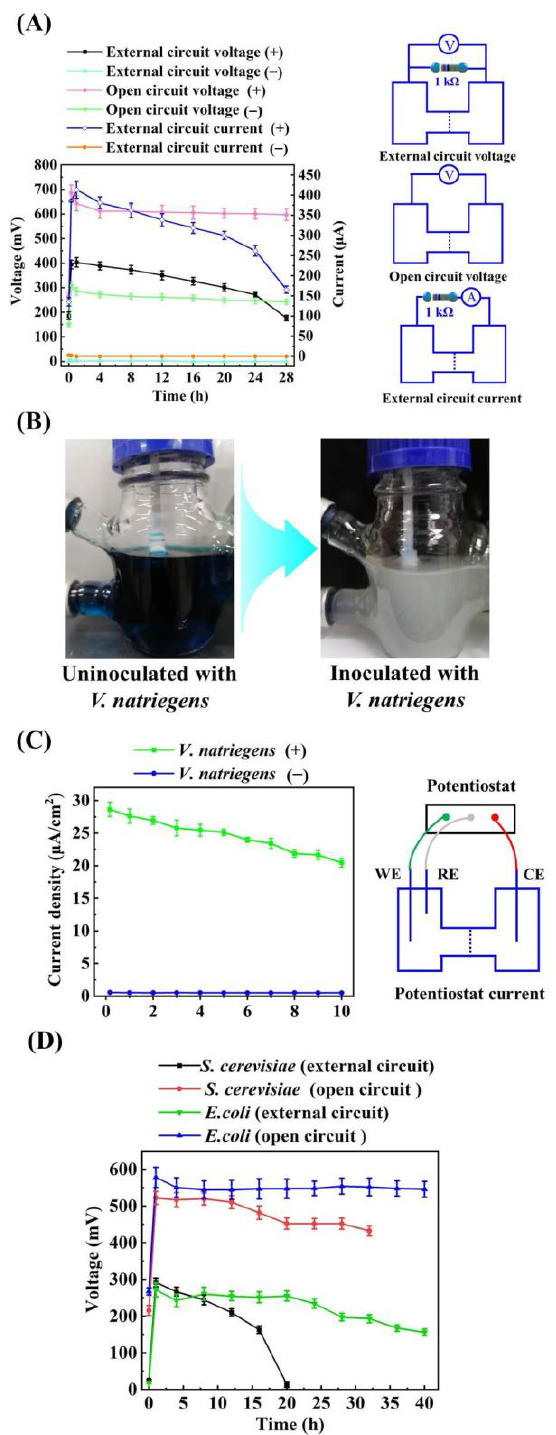
Figure 4. Bioelectricity generation of MFC with methylene blue as exogenous electron mediator. ( A